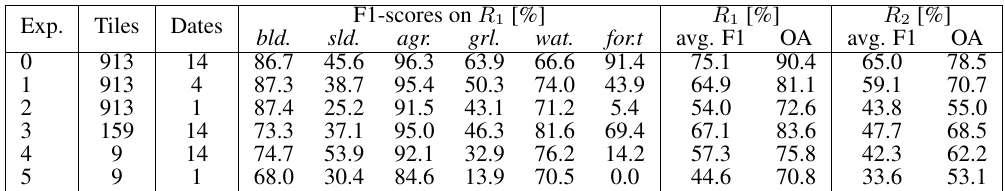
Table 3. Evaluation of land cover classification with different training datasets. Exp.: Experiment number. OA: Overall Accuracy. Noise Exp.